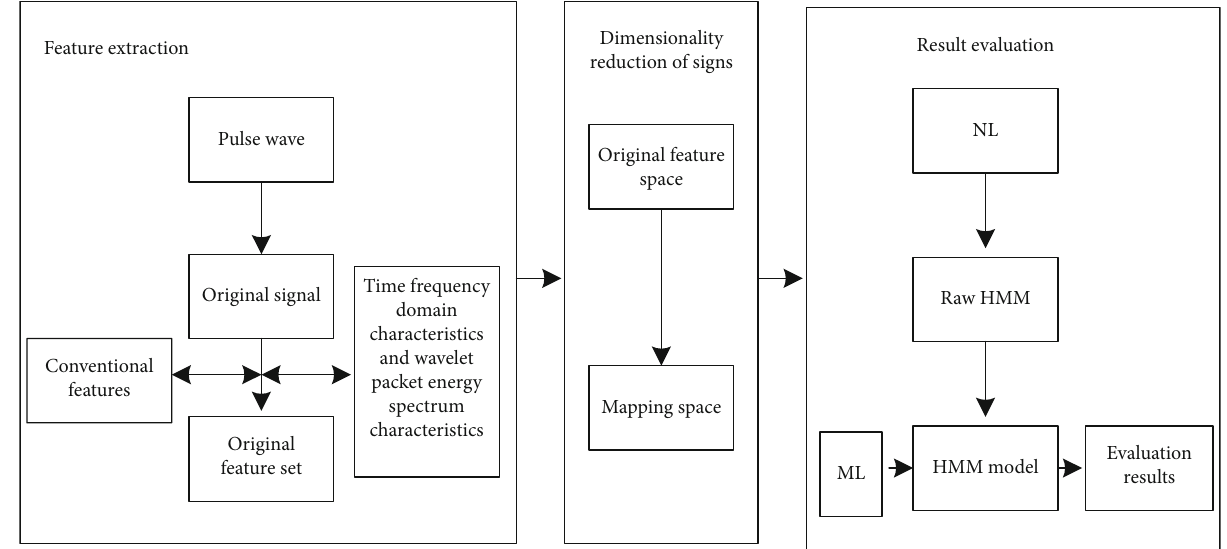
Figure 5: Process of health assessment model based on big data.